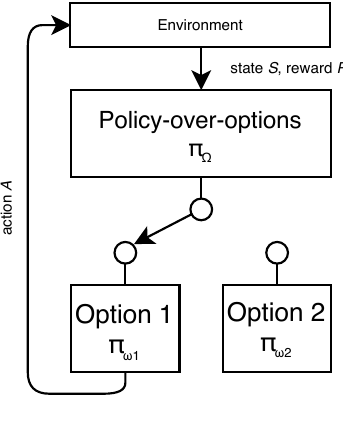
Figure 6. Options framework.